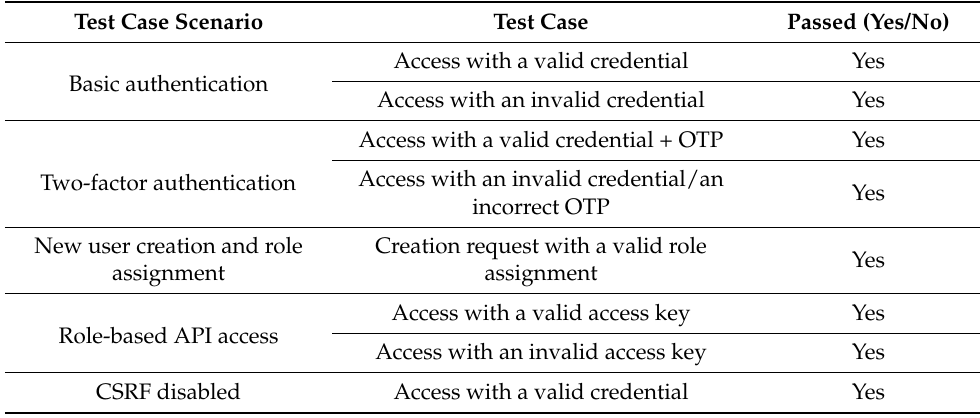
Table 15. Summary of the adopted functional and non-functional